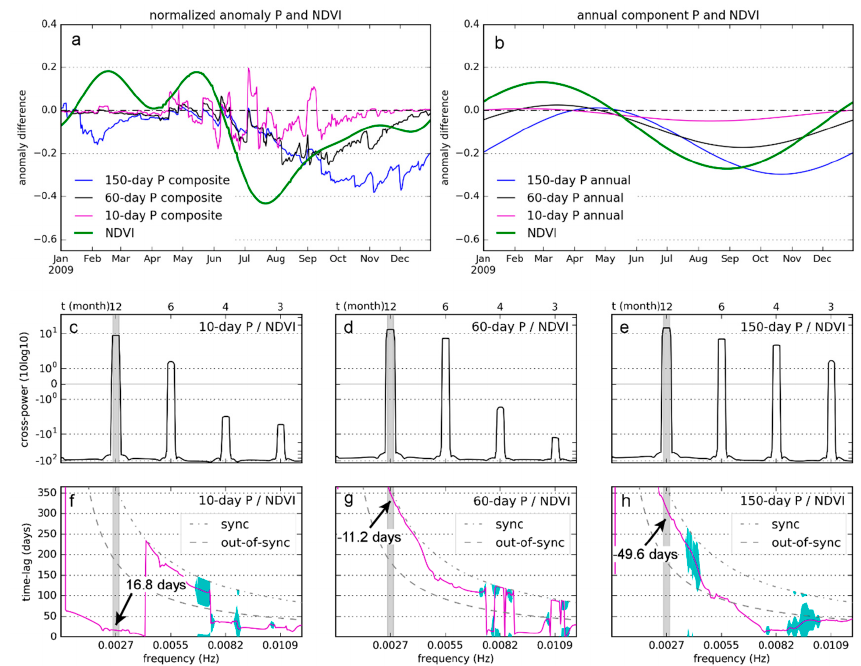
Figure 8. ( a ) Normalized anomaly time series of different durations of antecedent precipitation and NDVI; ( b ) annual component of the anomaly time series; ( c ) CSD for 10-day P and NDVI; ( d ) CSD for 60-day P and NDVI; ( e ) CSD for 150-day P and NDVI; ( f ) time lag + uncertainty of 10-day P and NDVI; ( g ) time lag of 60day P and NDVI; ( h ) time lag of 150-day P and NDVI.